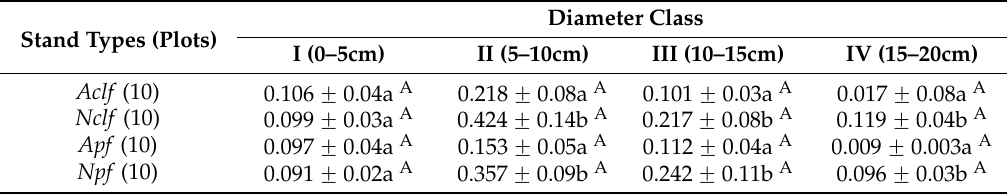
Different uppercase letters indicate significant differences among different forest types ( Cunninghamia lanceolata , Pinus massoniana ) of the same stand type (artificial or natural) ( p < 0.05). Different lowercase letters indicate significant differences among different stand types for the same forest type ( p <